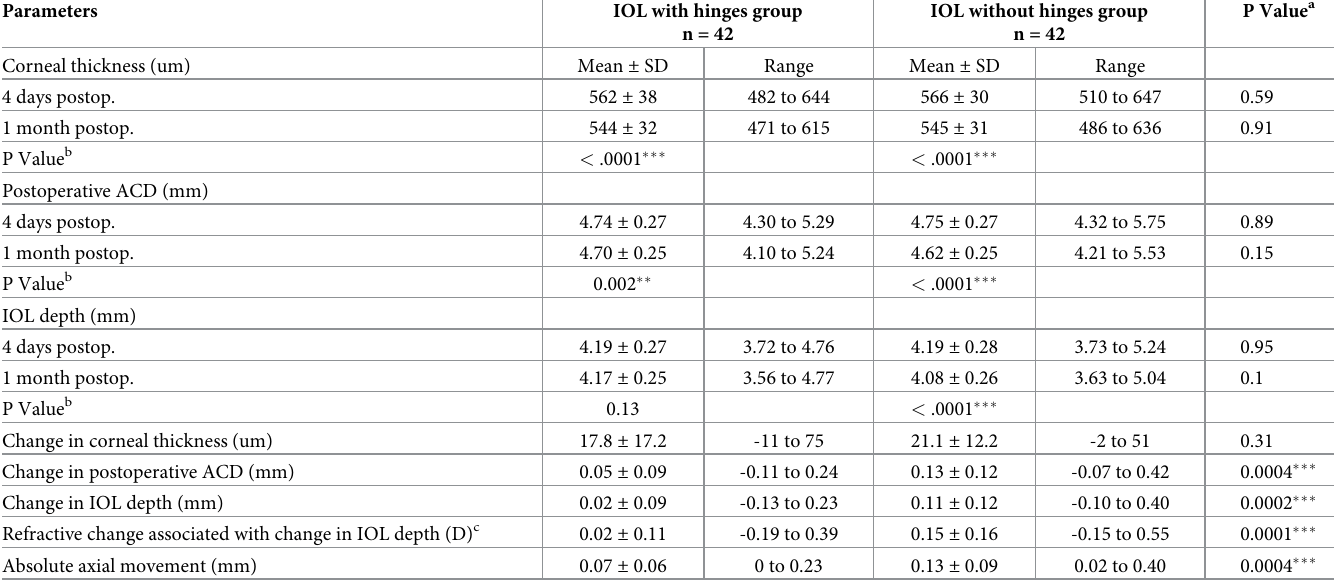
Table 2. Comparison of mean ( ± SD) corneal thickness, postoperative anterior chamber depth, and intraocular lens depth, change in each parameter and absolute axial movement.